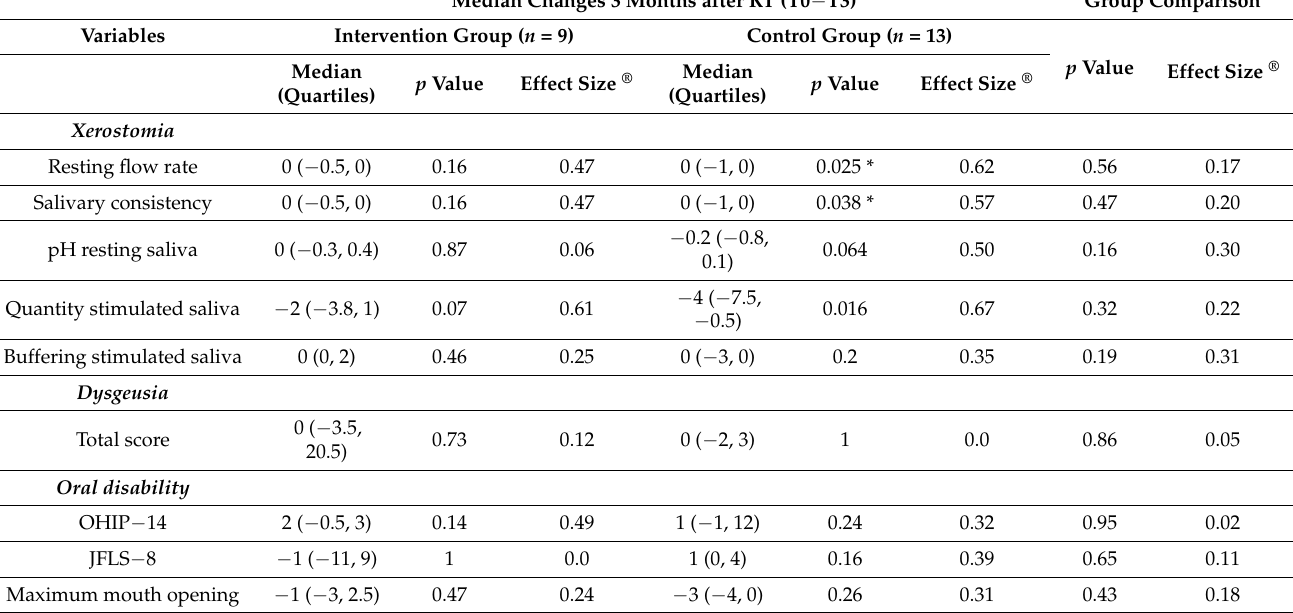
Table 2. The left part of the table shows the median changes in the outcome variables after three months, separately for the intervention and control groups. Negative values indicate a decrease, and positive values are an increase compared to the baseline measurements. Quartiles are shown in brackets. The significance of the changes was tested using a two-tailed Wilcoxon signed rank test. In the right part of the table (group comparison), the Mann-Whitney U test was used to test whether the observed changes T0–T3 would differ between the intervention and control groups. Exact p -values are given for all tests. Values below 0.05 are in bold. Effect sizes are reported using Pearson’s